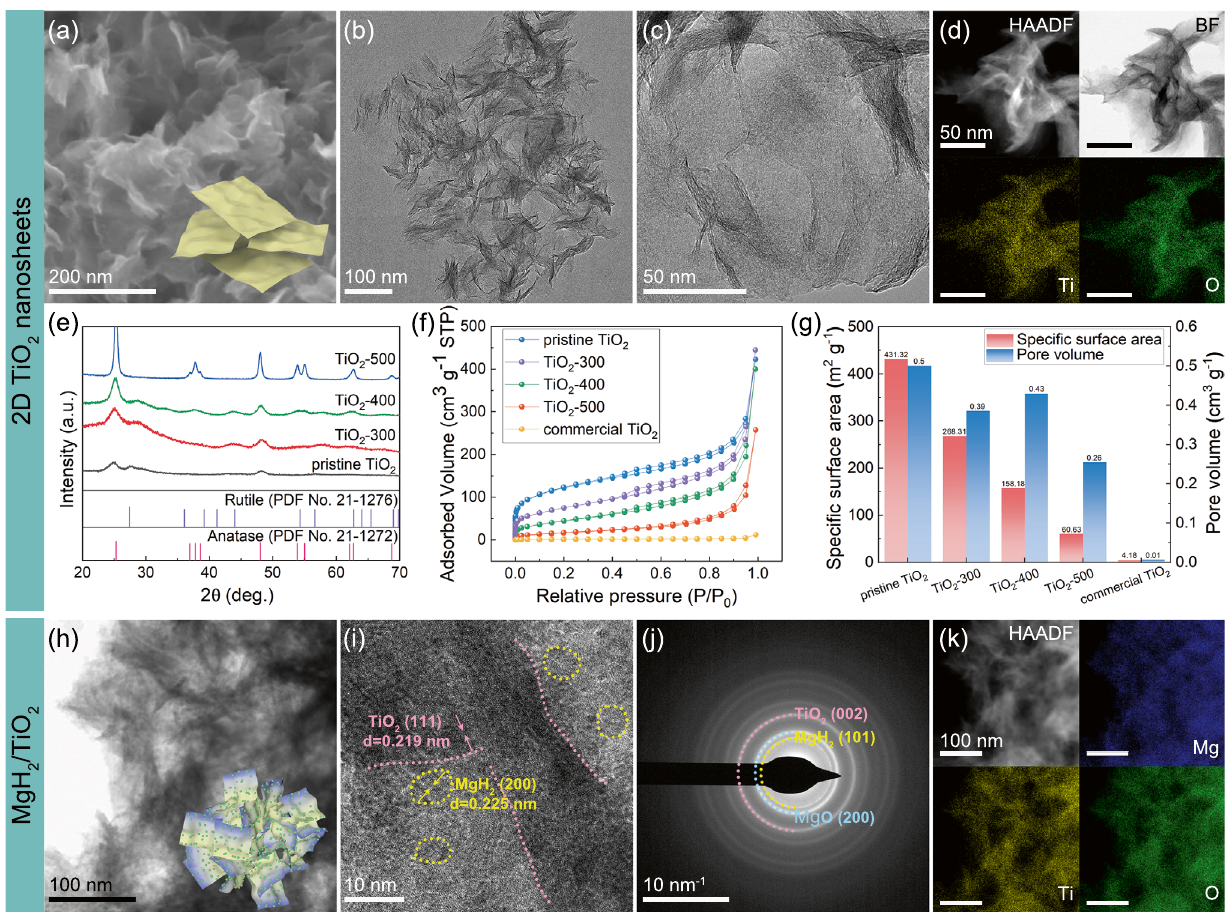
Fig. 1 a Typical SEM image of TiO 2 NS. b, c Typical TEM images at different scales. d Representative HAADF and BF images of TiO 2 NS as well as corresponding EDS elemental mapping results. e XRD patterns of TiO 2 NS. f, g N 2 ad/de-sorption isotherms and corresponding specific surface areas and pore-size distribution of pristine TiO 2 NS, commercial TiO 2 , and TiO 2 NS treated at different annealing temperatures. h‑j BF, HRTEM, and SAED images of as-synthesized 60MgH 2 /TiO 2 heterostructure. k HAADF images of as-synthesized 60MgH 2 /TiO 2 heterostructure and corresponding EDS elemental mapping